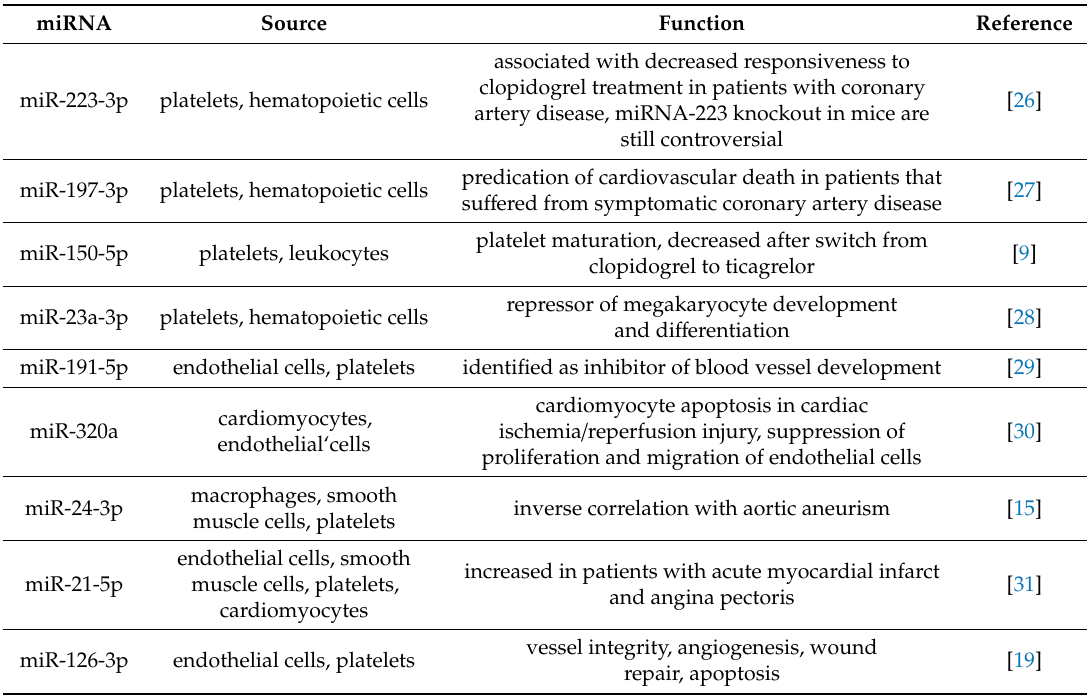
Table 1. Overview of selected